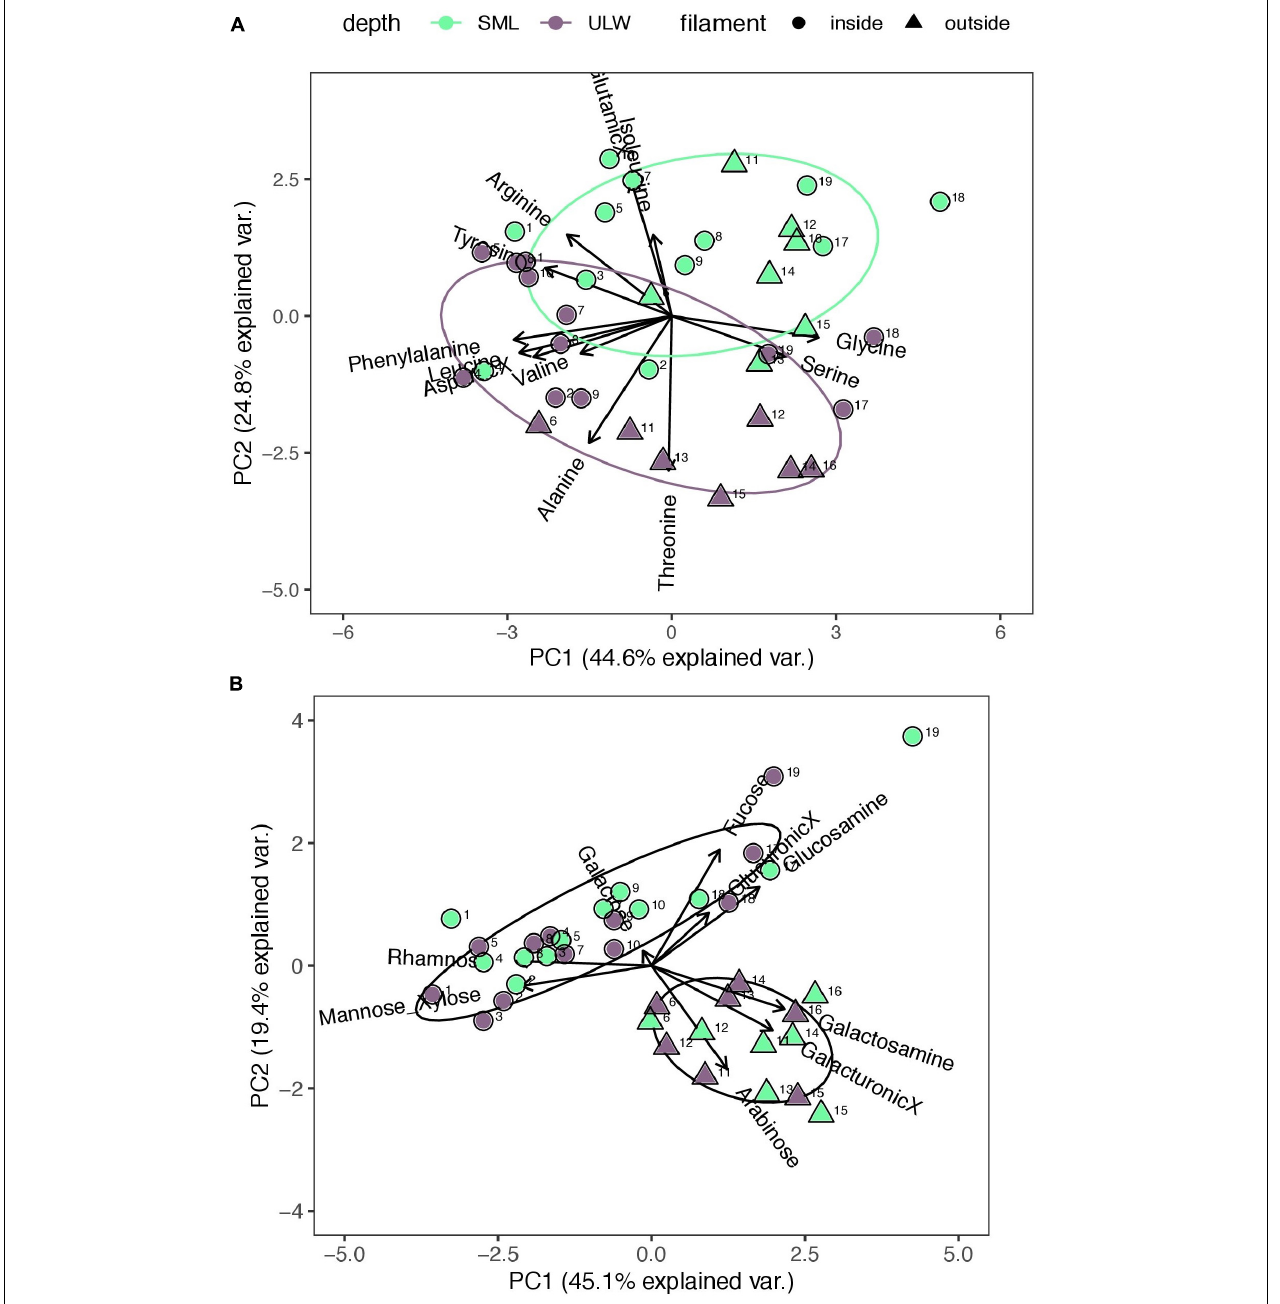
FIGURE 5 | Principal Component Analysis (PCA) of (A) total hydrolysable amino acid (TAA) and (B) total combined carbohydrate (TCHO) composition ( N = 38). Arrows indicate the relative molar contribution of TAA and TCHO. SML and ULW are represented by the colors green and gray, respectively. Circles and triangles represent the hydrological regime, i.e., inside and outside the